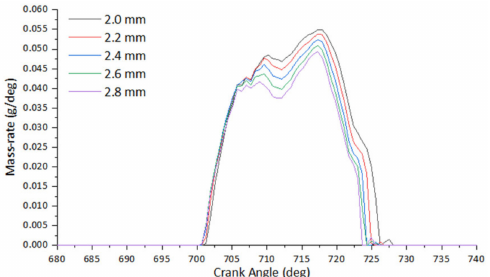
Figure 9. Fuel injection rate under varied pipe diameters.